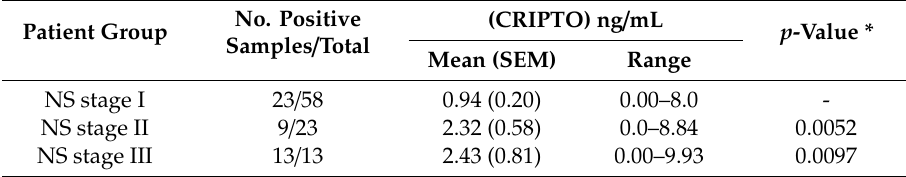
Table 2. CRIPTO concentration according to disease stage in the serum cohort.